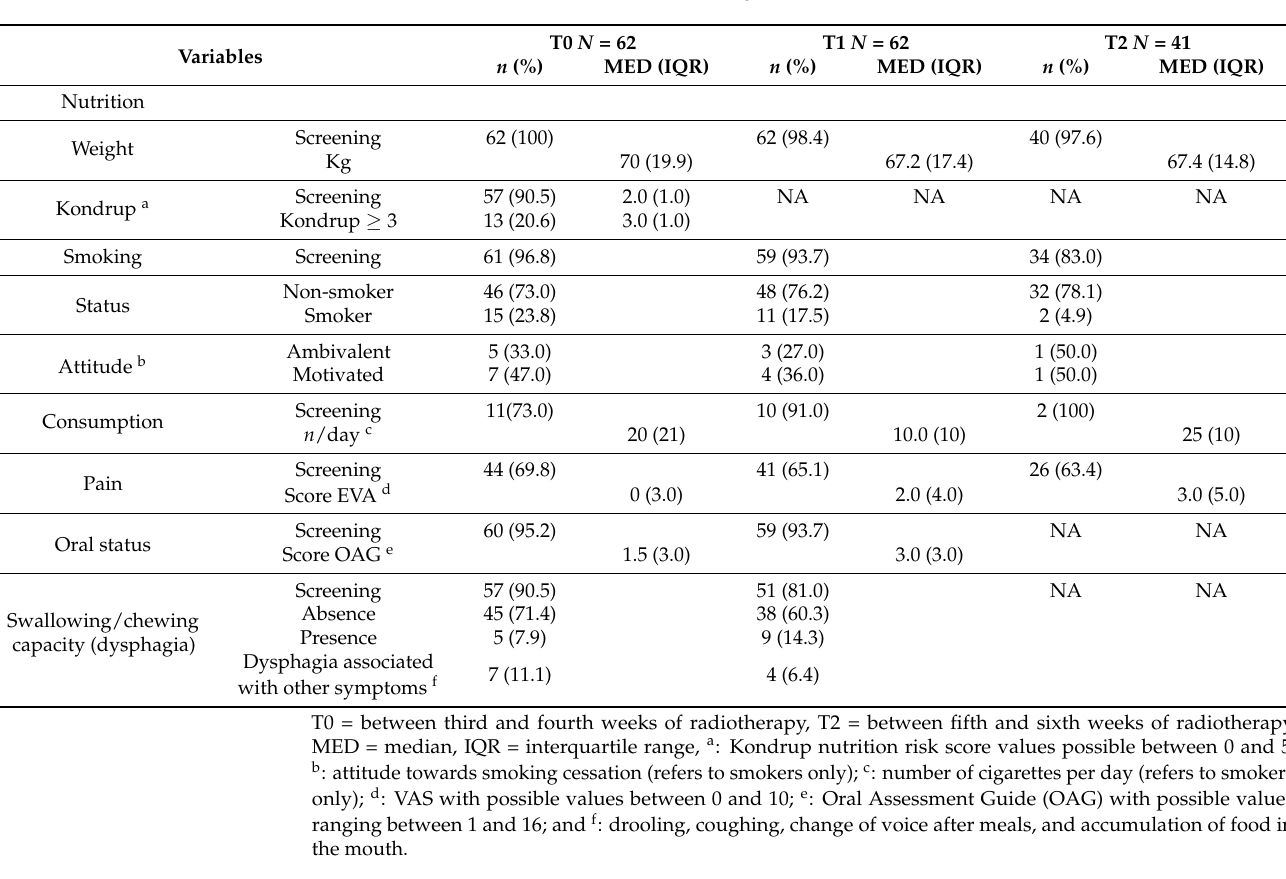
Table 3. Results of the data collection during nurse-led consultations.